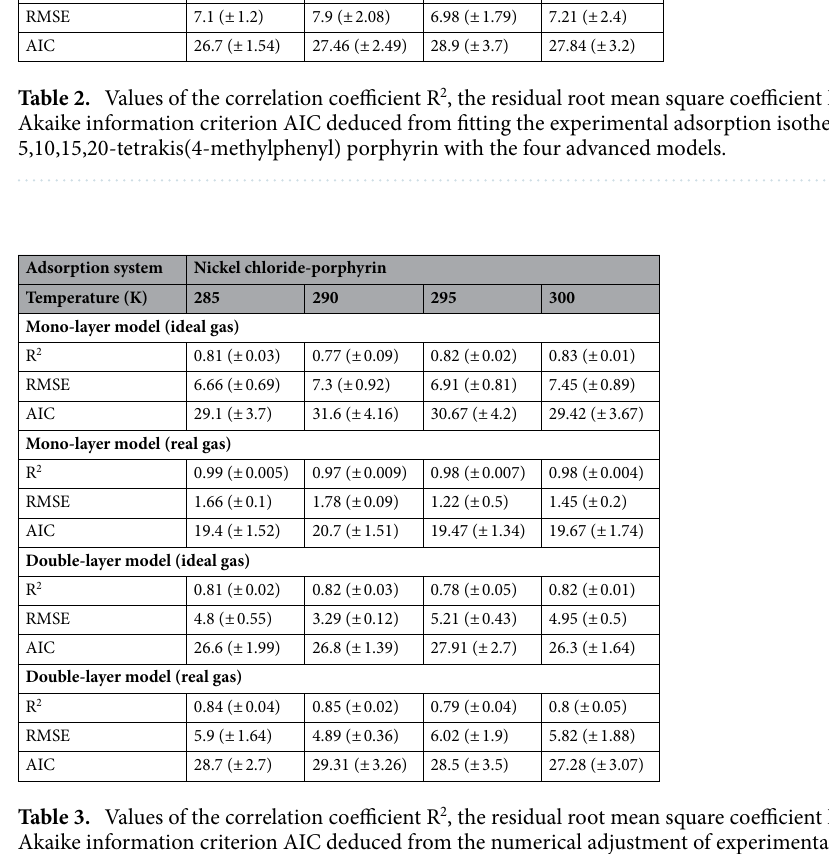
Models’ parameters and physicochemical discussion. The chosen models for the isotherms-curves’ description, as seen in Table 1, include steric parameters and energetic variables. By steric parameters, we mean the metals-number per porphyrin site n and the occupied adsorbent sites number P M . By energetic variables, we mean c 1/2 for zinc, w 1/2 for nickel and c 1 and c 2 for chromium. The description of nickel adsorption is done by the cohesion pressure a and the covolume b which represent the lateral interactions variables. The adsorption systems’ parameters values are given in Table 5. Steric parameters n and P M and lateral interactions’ parameters a and b. The steric parameters pave the way for a comparison between the performances of the three systems as far as quantity is concerned 63 . According to Table 5 and at a temperature T equal to 300 K, it is noticeable that: